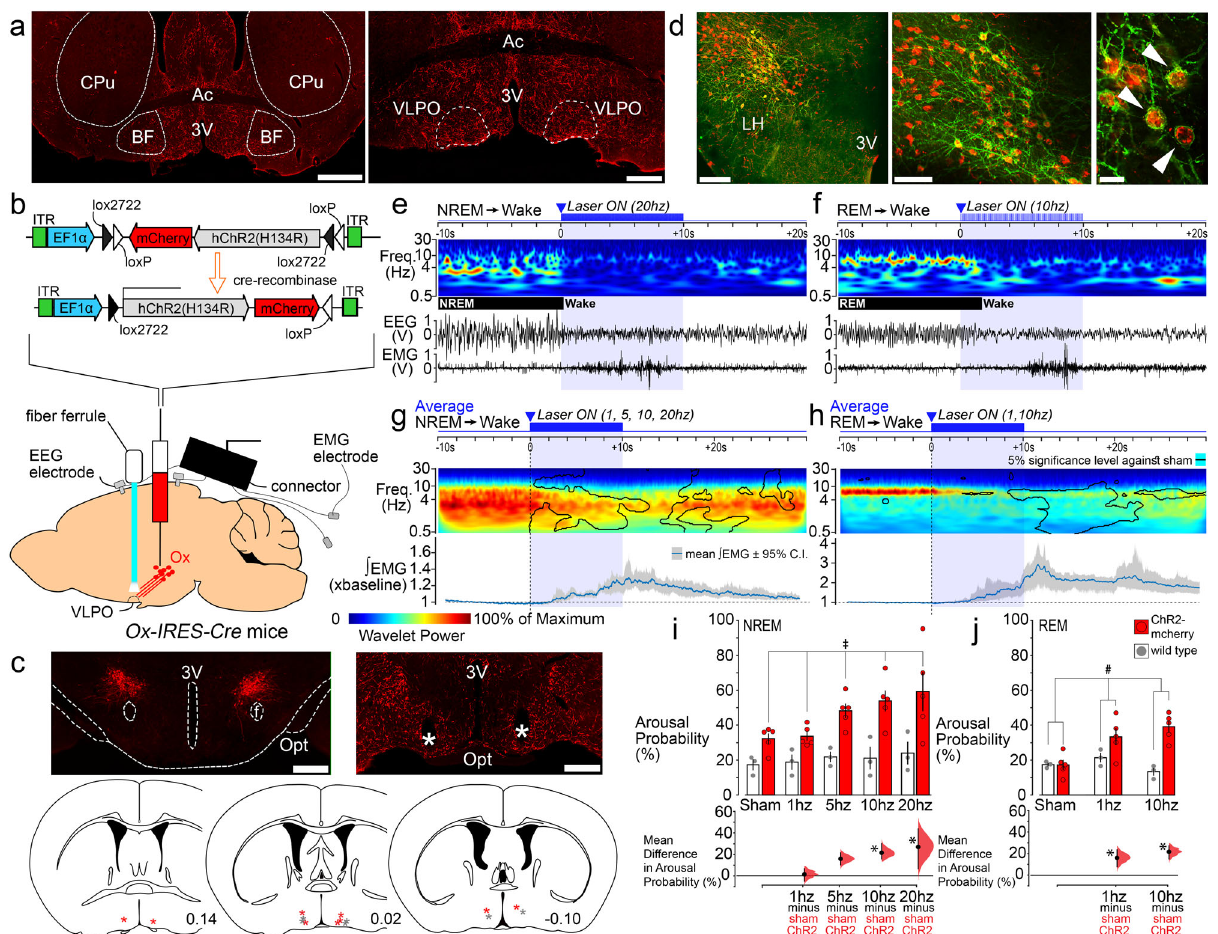
Fig. 1 Optogenetic stimulation of orexin terminals in the VLPO rapidly triggers arousals from both NREM and REM sleep. a Orexin innervation of the POA and VLPO (scale bars: 1 and 0.5 mm). b AAV-DIO-ChR2-mCherry was injected bilaterally into the Ox fi eld of Ox-IRES-Cre mice and optical fi bers bilaterally placed above the VLPO. c Orexin neurons transduced with ChR2- mCherry (red; left) and optical fi ber (*) above the VLPO (right; scale bars: 500 µ m). Optical fi ber placements (red * ChR2-mCherry and grey * WT; bottom). d ChR2-eYFP( + ) neurons double-labeled for Ox-A (in red; scale bars: 200; 100, and 20 µ m). Laser-induced arousals from NREM ( e ) and REM ( f ) sleep (10 s-long periods before and after 10 s light pulses, top). EMG and EEG recordings and continuous EEG wavelet transforms (bottom). Trial-averaged responses to laser stimulation in NREM ( g ) and REM ( h ) sleep. EEG wavelet power for trials containing arousals (top; n = 5). Black contour lines: 5% signi fi cance level against sham trials (paired bootstrap con fi dence interval of the mean wavelet power difference). EMG mean responses (grey region: 95% bootstrap con fi dence interval; bottom). Mean differences in arousal probability, from NREM ( i ) and REM sleep ( j ) in ChR2-mCherry ( n = 5) and WT ( n = 3; top). On the bottom, the mean differences in arousal probability (stimulation vs. sham) within the ChR2-mCherry group (NREM: effect of genotype F (1, 24) = 22.92, p = 0.003; interaction between genotype and stimulation frequency F (4, 24) = 1.66, p = 0.192, two-way ANOVA one-repeated-measure. REM: interaction between genotype and stimulation frequency F (2, 12) = 7.02, p = 0.010, two-way ANOVA one-repeated-measure). Mean difference in arousal probability from NREM ( i , bottom; t = 2.98 and 3.73, p = 0.019 and 0.004 for 10 and 20 Hz stimulations) and REM sleep ( j , bottom; t = 3.82 and 5.16, p = 0.002 and 0.0007 for 1 and 10 Hz stimulations; post-hoc Holm – Š idák t -tests, two-way ANOVA one-repeated-measure; n = 5; Source Data fi le). Error bars: SEM; ‡ : signi fi cant for factor genotype (two- way ANOVA); #, signi fi cant interaction between the factors genotype and stimulation frequency (two-way ANOVA). Mean differences (stimulations vs sham within the ChR2-mcherry group) plotted as bootstrap sampling distributions (bottom). Dots: mean difference in arousal probability; vertical error bars: 95% con fi dence intervals; * p < 0.05 post-hoc Holm – Š idák t -test. All testing was two-tailed, and n refers to the number of independent animals.